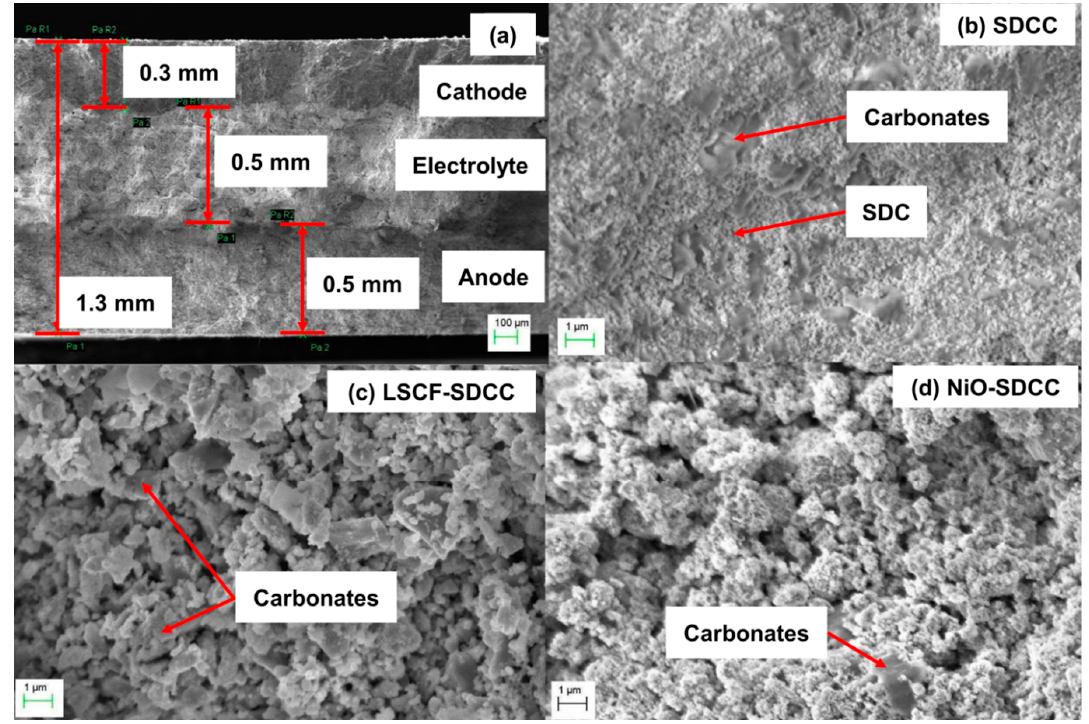
Figure 2. Cross-section FESEM images of ( a ) uniaxially pressed single-cell solid oxide fuel cell (SOFC), ( b ) SDCC composite electrolyte, ( c ) LSCF–SDCC composite cathode, and ( d ) NiO–SDCC composite anode.